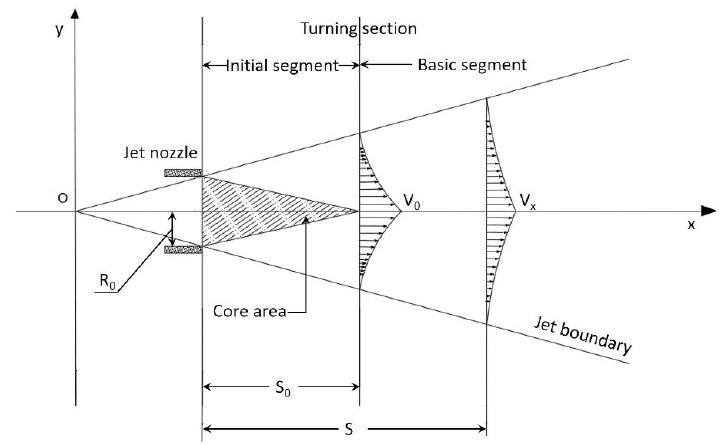
Figure 5. The structure of the submerged water jet, modified from Yanaida and Ohashi [51]. 𝑅 (cid:2868) is the water jet radius, 𝑠 (cid:2868) is the axial length of the initial segment, 𝑠 is the jet distance, 𝑣 (cid:2868) is the jet velocity at the nozzle outlet, and 𝑣 (cid:2934) is the axial velocity.